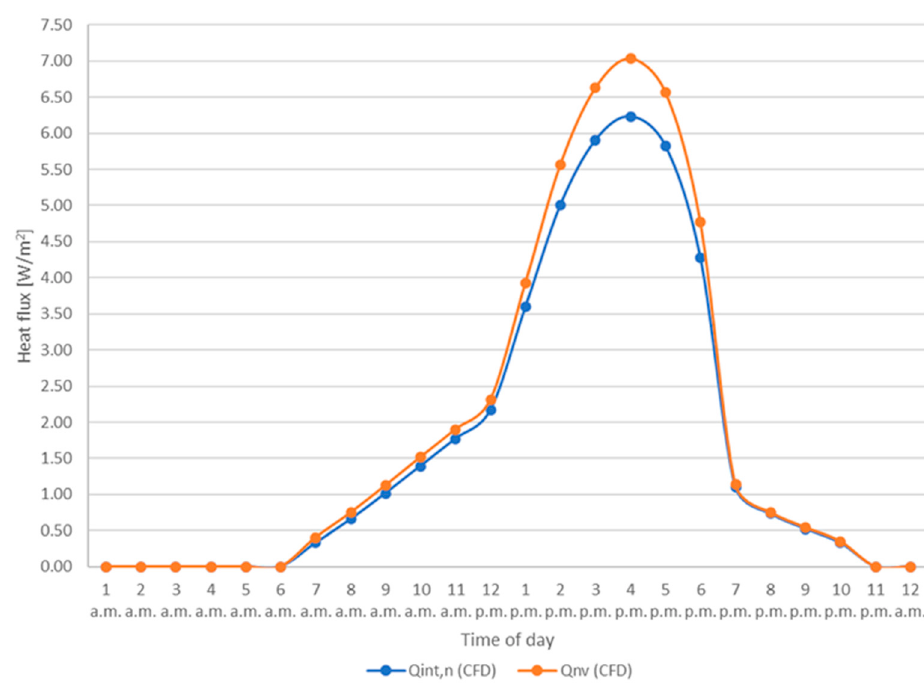
Figure 17. Comparison between the heat fluxes entering the building through the naturally ventilated façade (Q int,n ) and the unventilated façade (Q nv